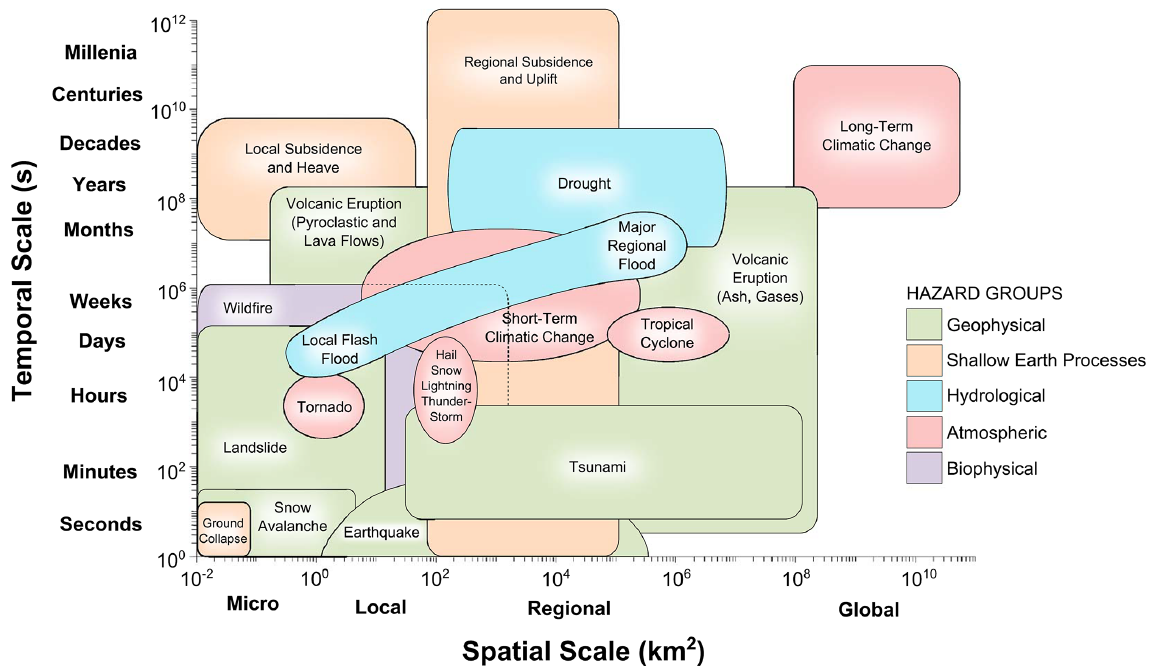
Figure 1. Spatial and temporal scales of 16 natural hazards. Shown on logarithmic axes are the spatial and temporal scales over which the 16 natural hazards act. Here spatial scale refers to the area that the hazard impacts and temporal scale to the timescale on which the single hazard acts upon the natural environment. Hazards are grouped into geophysical (green), hydrological (blue), shallow Earth processes (orange), atmospheric (red), and biophysical (purple). From Gill and Malamud (2014).